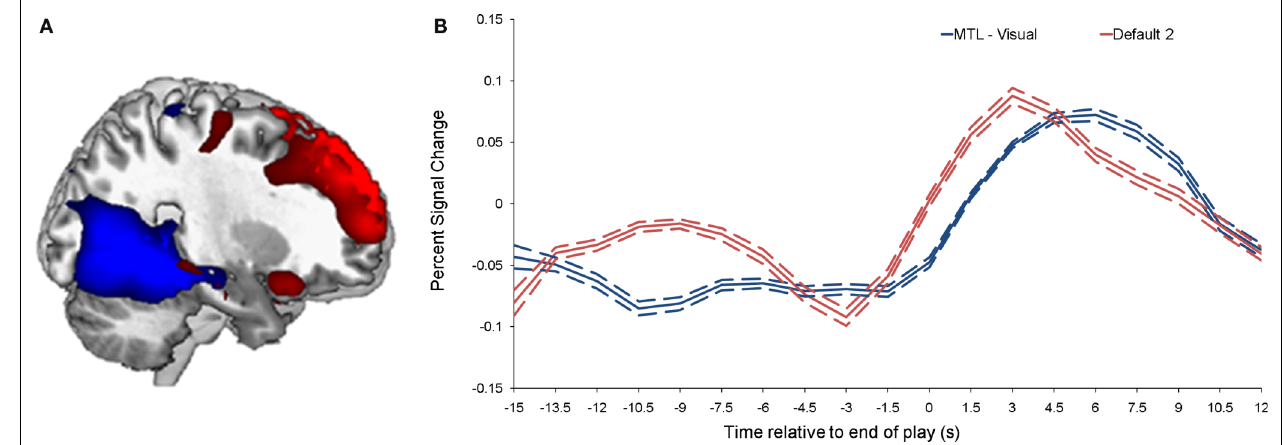
FIGURE 2 | Brain activity related to the two ICs that correlated with emotional intensity ratings. (A) Shows the “MTL-visual IC” (blue) and the “default network IC2” (red), and their corresponding time-courses are shown in (B) . The dotted lines indicate the standard deviation.